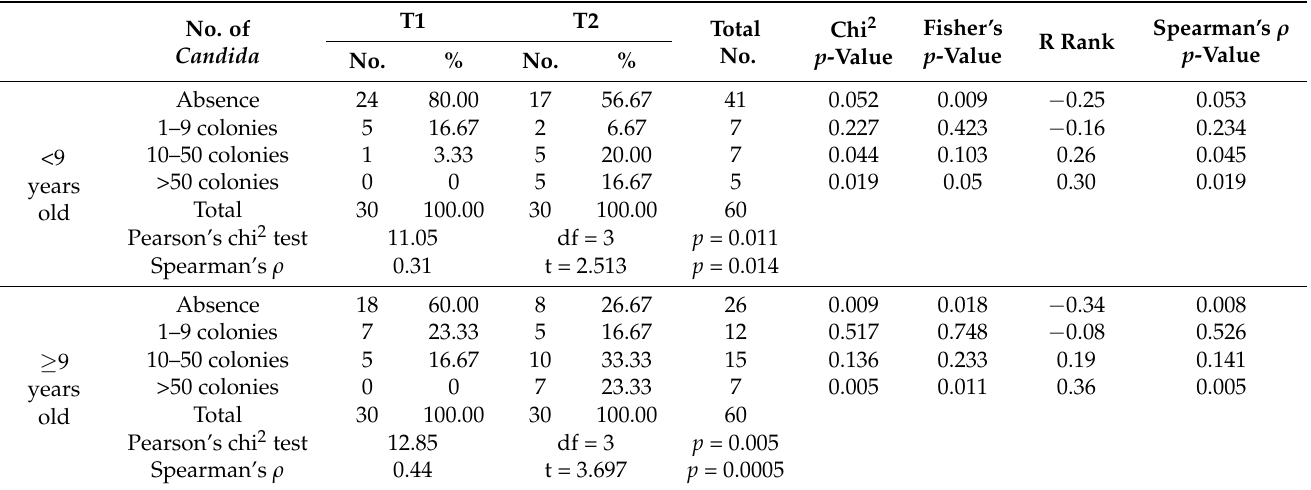
Table 5. Analysis of the relationship between fungal colony results and patient age.